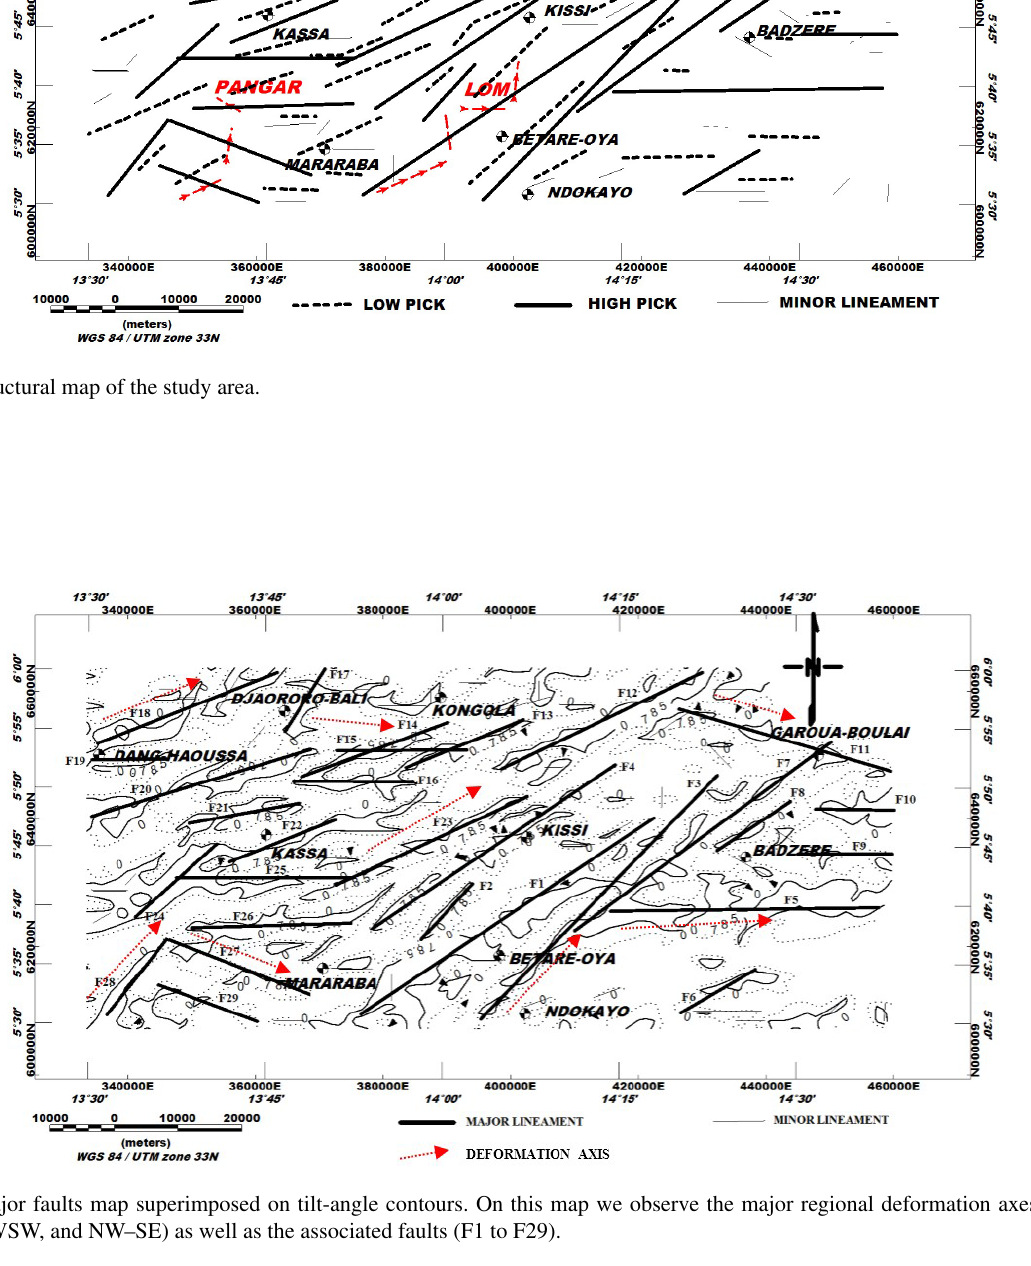
https://doi.org/10.5194/se-12-785-2021 Solid Earth, 12, 785–800,